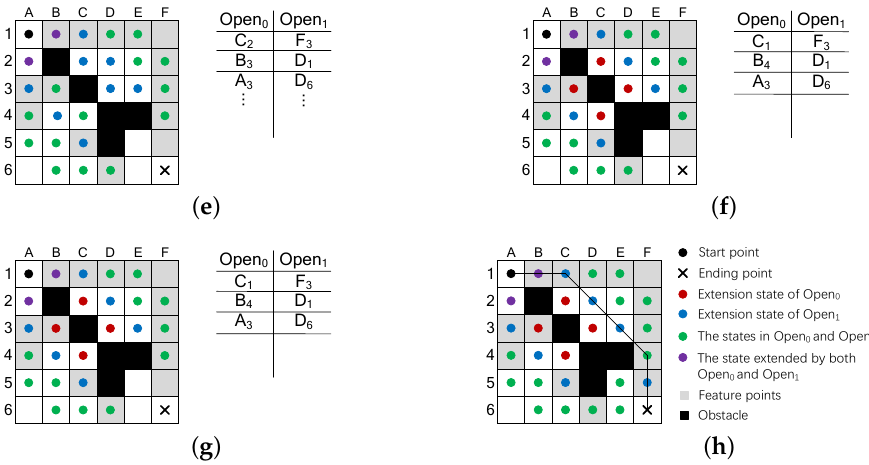
Figure 5. 2D illustration of the RA* algorithm. ( a ) Since there are only starting states in OPEN cost and OPEN nor , the condition of simultaneous extension is met. After extension, s 0 = f ( b 1 ) . ( b ) Same as the first step. ( c ) The ordinary A* algorithm will extend A 2 , while our algorithm will give priority to the maximum state of Nor to extend, so as to ensure as many traversal of ridge points as possible, so it will extend C 1 at this time. ( d ) The effect after expansion is reflected in Figure 5d. ( e ) After several extensions, all the states in OPEN nor exceed the limit condition, then the limit needs to be further increased so that the states in OPEN nor can continue to expand, then s 0 is expanded separately.